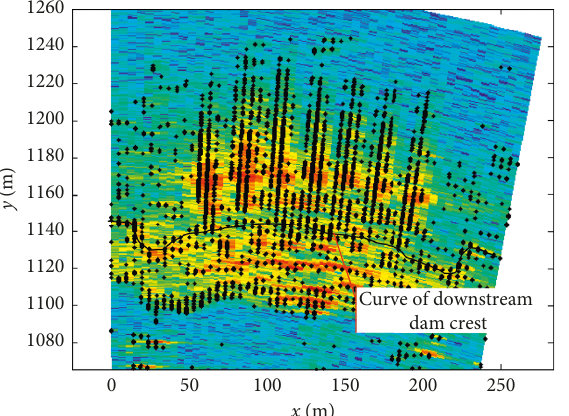
Curve of downstream dam